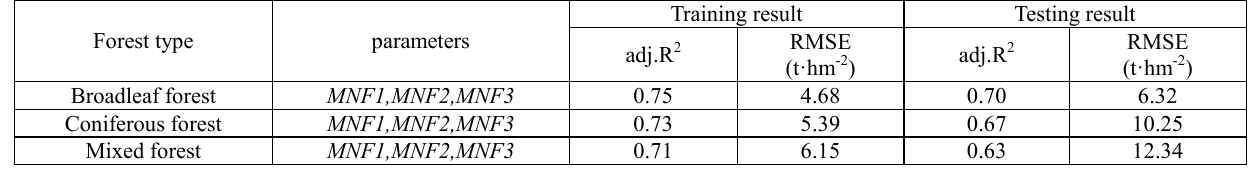
Table.5 Results of forest AGB models estimated with HJ-1A/HSI parameters